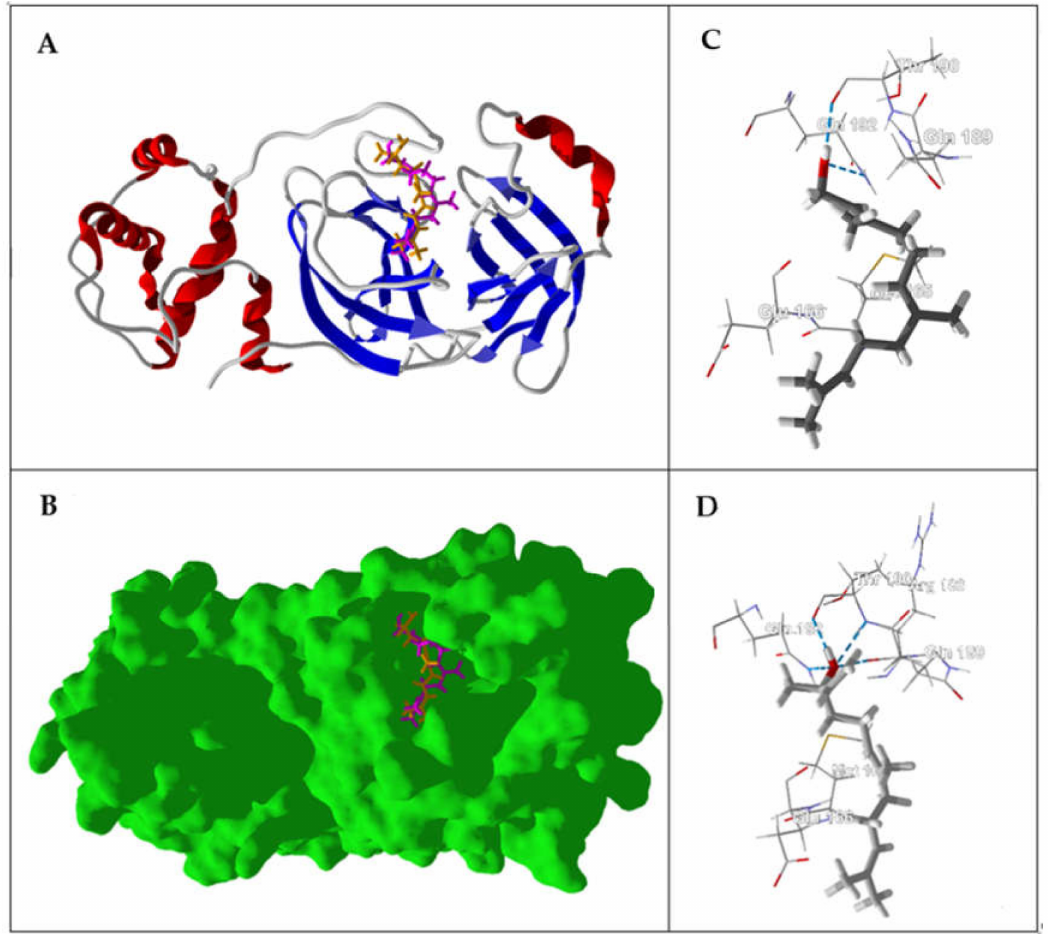
Figure 2. Lowest-energy docked poses of ( E , E )-farnesol and ( E )-nerolidol with the SARS-CoV-2 main protease (PDB: 6Y84). ( A ) Ribbon structure of the enzyme and ( E , E )-farnesol (magenta) and ( E )-nerolidol (orange). ( B ) Solid structure of the enzyme showing ( E , E )-farnesol (magenta) and ( E )-nerolidol (orange) in the binding cleft. ( C ) Important interactions of amino acid residues with ( E , E )-farnesol. ( D ) Important interactions of amino acid residues with ( E )-nerolidol. Hydrogen bonds are indicated with blue dashed